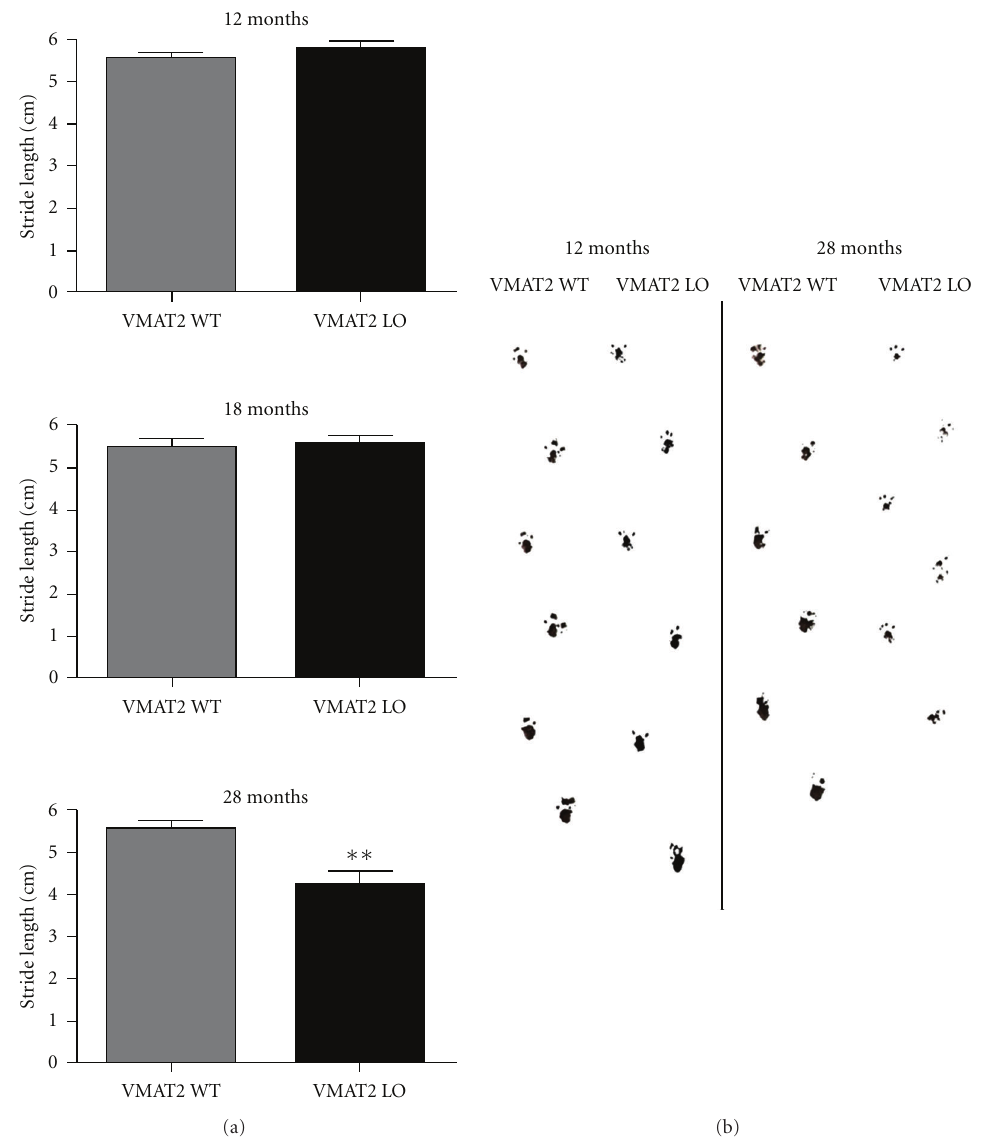
Figure 1: VMAT2-deficient animals display impaired stride length at older ages. (a) No deficits in forepaw stride length were apparent at 12 or 18 months of age in VMAT2-deficient mice. At 28 months of age, VMAT2-deficient mice display motor deficits as measured by inked paw stride length. Results represent average stride length (cm) ± SEM for 4–6 animals per genotype, ∗∗ P < . 01. (b) Representative forepaw stride lengths for VMAT2 WT and deficient mice at 12 and 28 months of